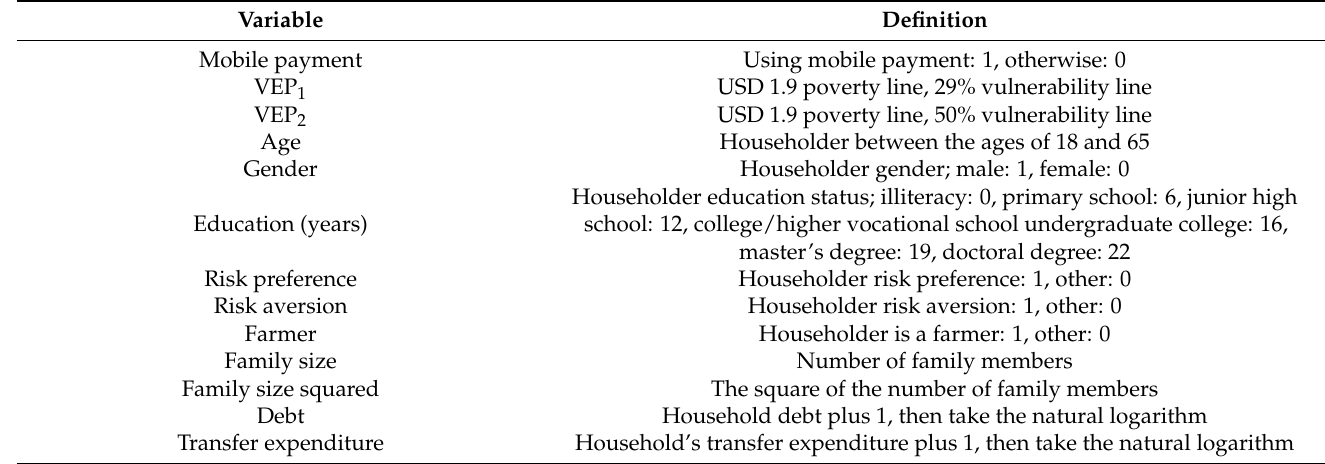
Table 2. Variable